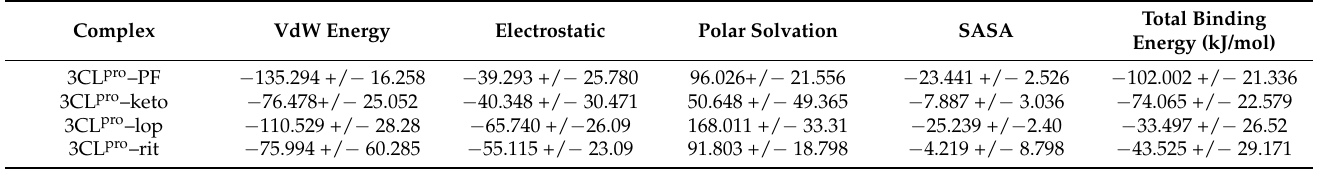
Table 2. Binding energy of 3CL pro and HIV-I protease complexes as computed via the g_mmpbsa method.